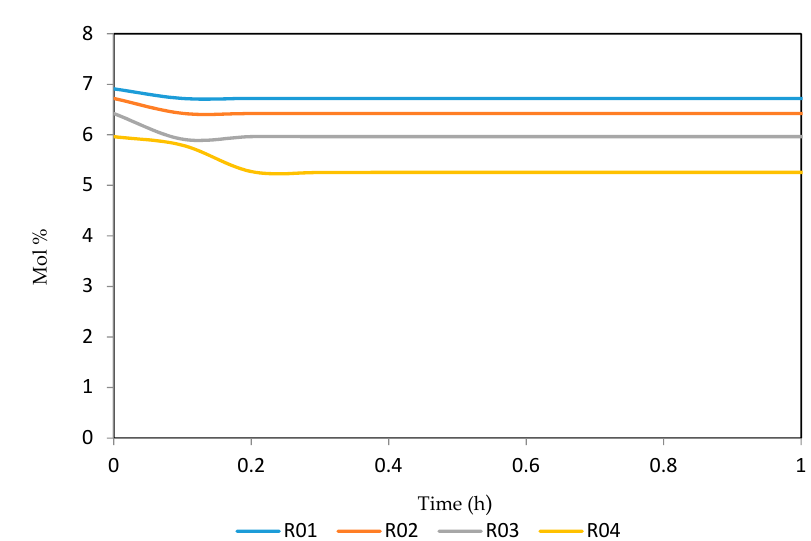
Figure 18. Dynamic behaviour of P 8 in the four reactors.